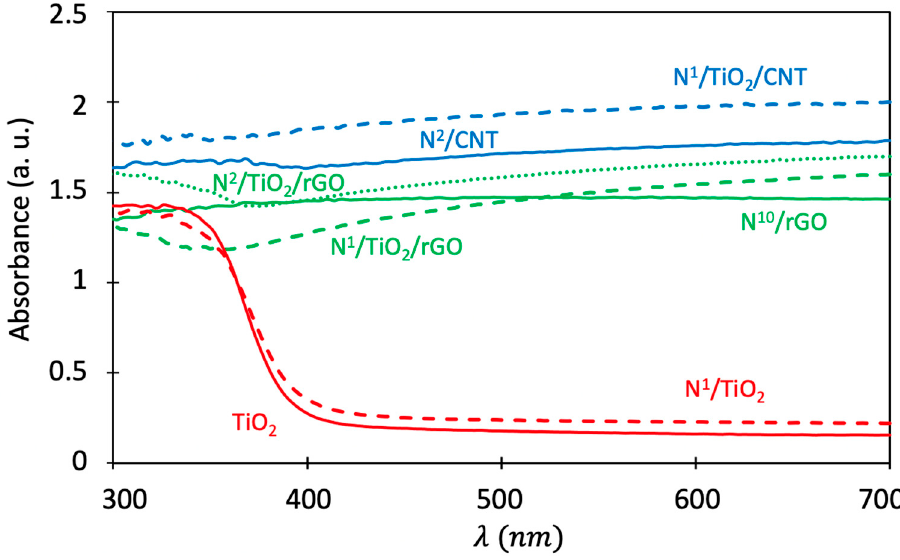
Figure 11. DRS spectra of different synthesized N-doped TiO 2 -based photocatalysts and